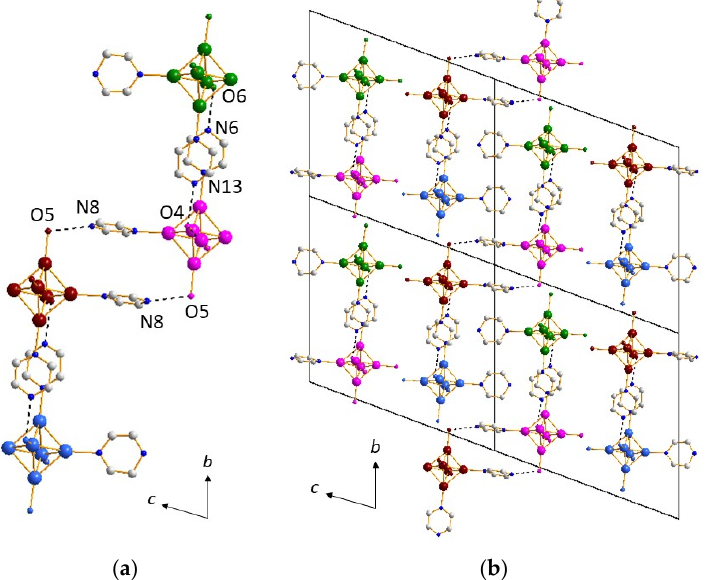
Figure 4. ( a ) Connection of the tunnels through H bonds involving the pyrazine cycles in the structure of ( 2 ). ( b ) Projection along the a axis of the supramolecular framework of ( 2 ). Compound ( 3 In contrast to the aforementioned compounds ( 1 ) and ( 2 ) based on neutral